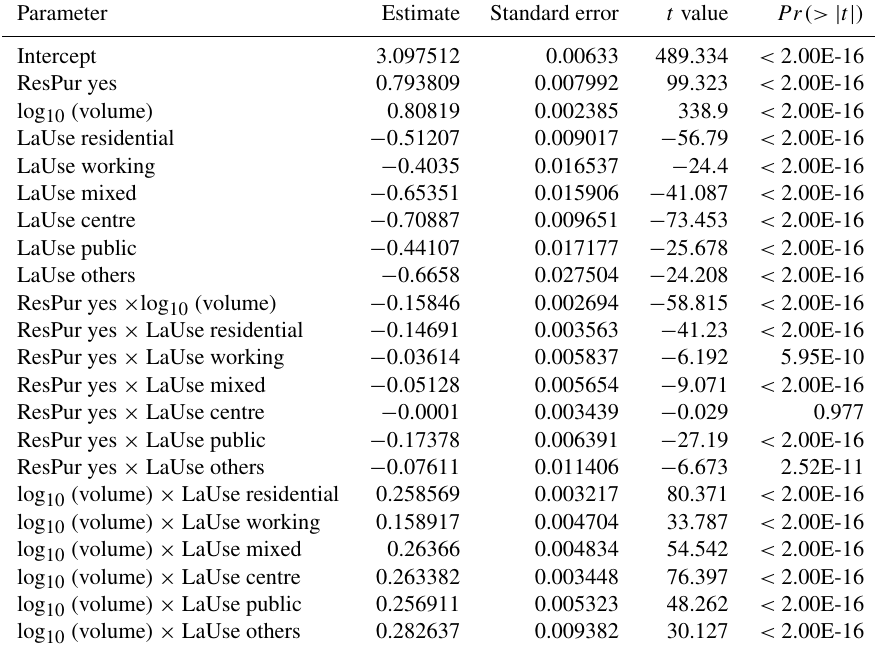
Table 4. Parameter estimates, standard errors, and t and p values of the three explanatory variables (and their pairwise interaction) of model M5. The three explanatory variables are residential purpose (ResPur) with values yes and no, the building volume above ground in m 3 (volume) and land use (LaUse) with values residential, working, mixed, centre, public, others and outside (i.e. area outside building zones). The intercept stands for the variable values of log 10 (volume) = 0 (i.e. volume = 1m 3 ); ResPur=no and